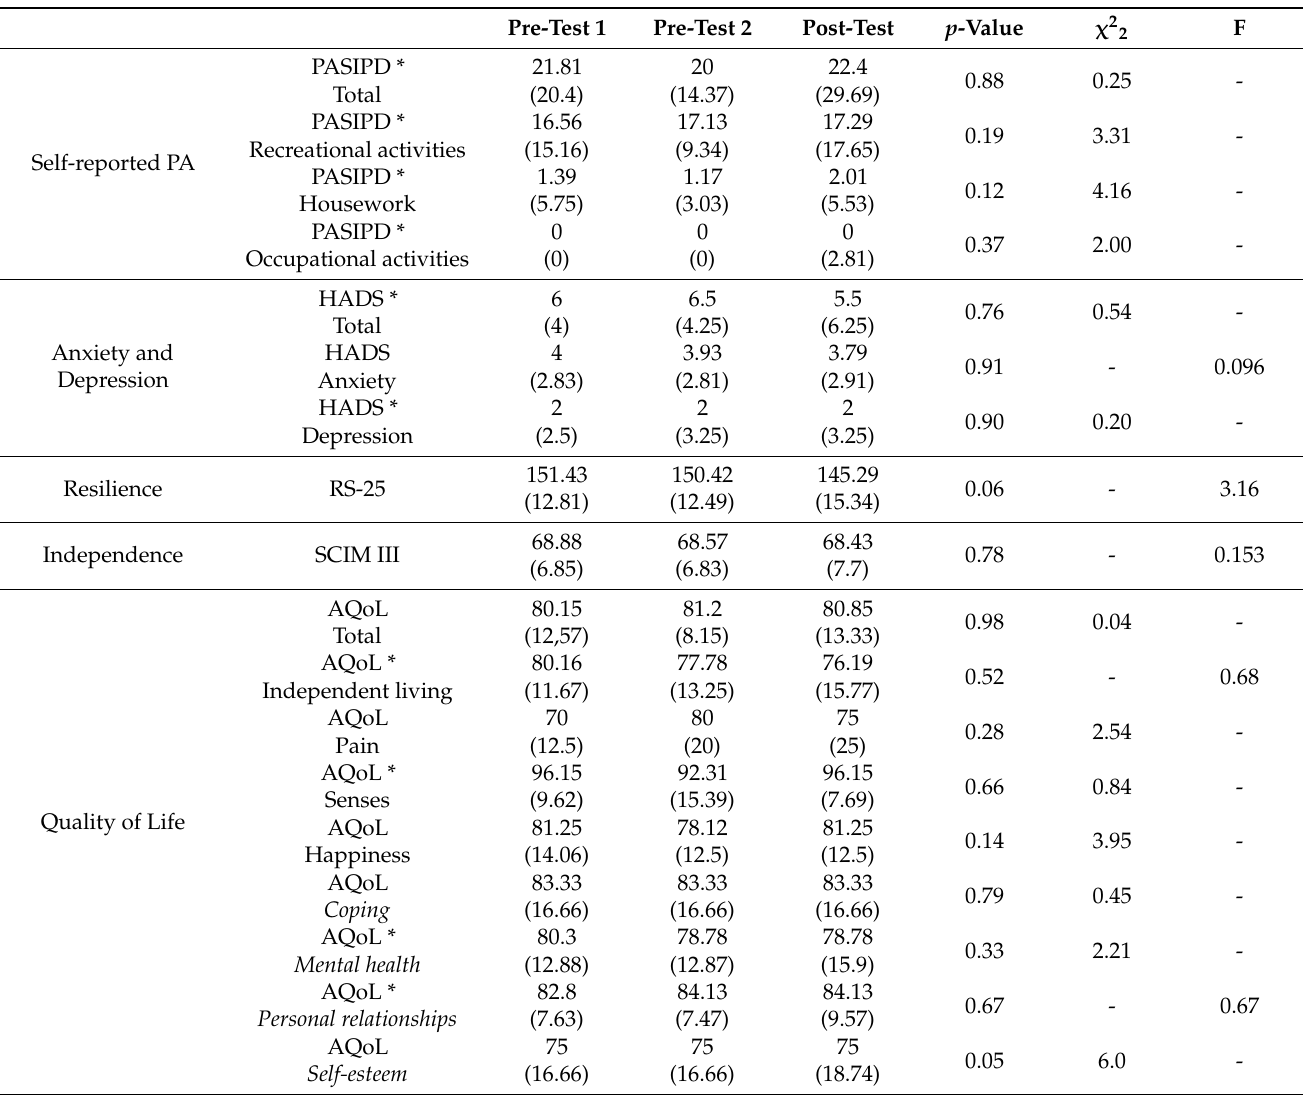
Table 2. Descriptive statistics for each variable extracted from the questionnaires at each measure- ment